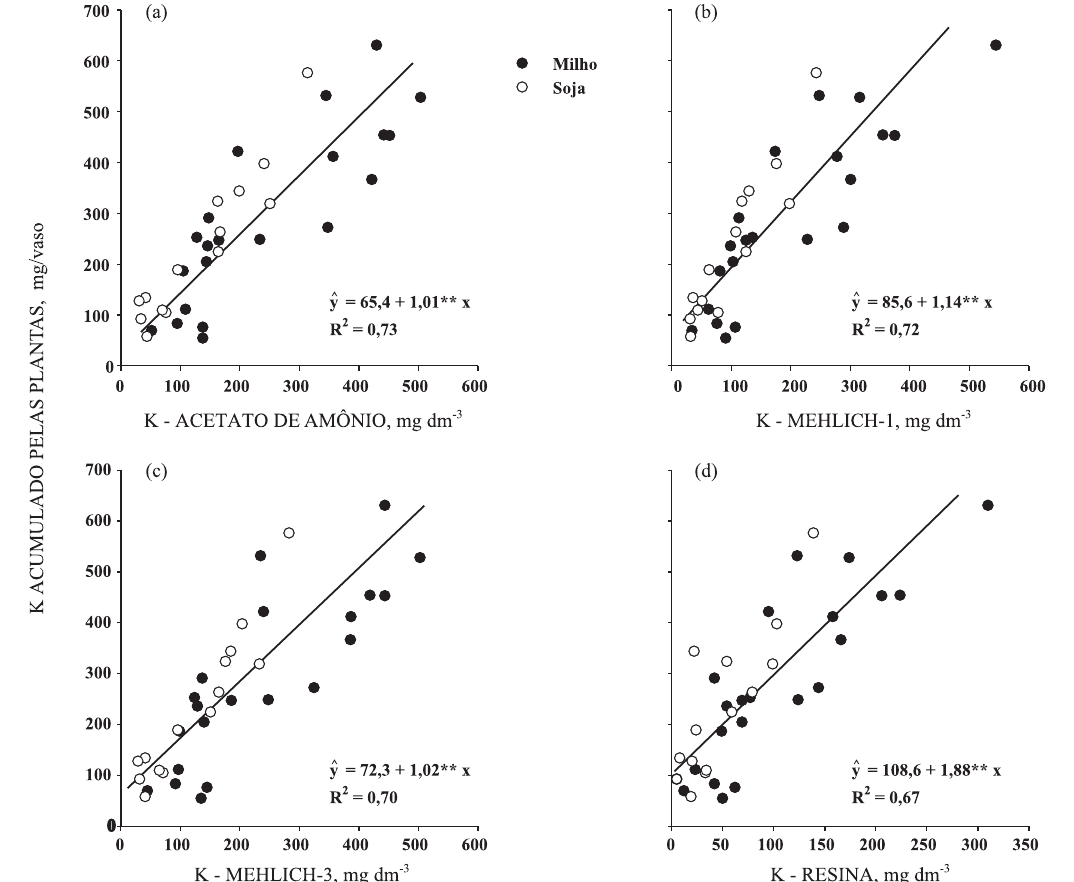
Figura 2. Relação entre os teores de potássio extraídos pelas soluções de acetato de amônio (a), Mehlich-1 (b), Mehlich-3 (c) e por resina (d) e a quantidade acumulada de potássio pelas plantas de milho e